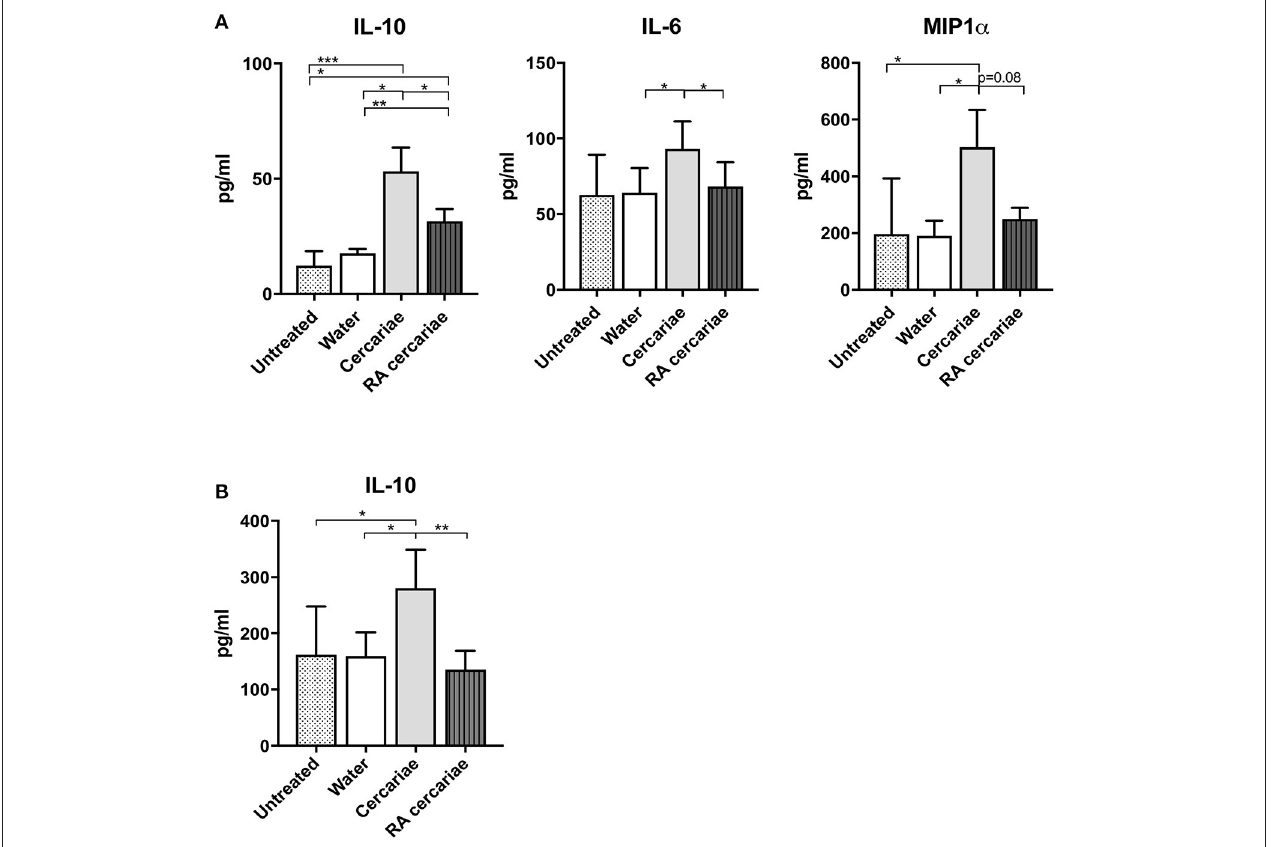
FIGURE 4 | Increased production of IL-6 and IL-10 and MIP1 α in skin exposed to cercariae. Whole biopsy cytokine analysis at 3 days post exposure to non-attenuated Sm cercariae show an increase in IL-6, IL-10 and MIP1 α . The effect is less pronounced in radiation attenuated cercariae. (A) . IL-10 production by DDCs after co-culture of emigrated DDCs with CD40L expressing cell line, 7 donors. ( B ). Data shown in pg/ml, mean ± SEM. * p < 0.05, ** p < 0.01, *** p < 0.001 using paired Student’s T- test on log transformed data.